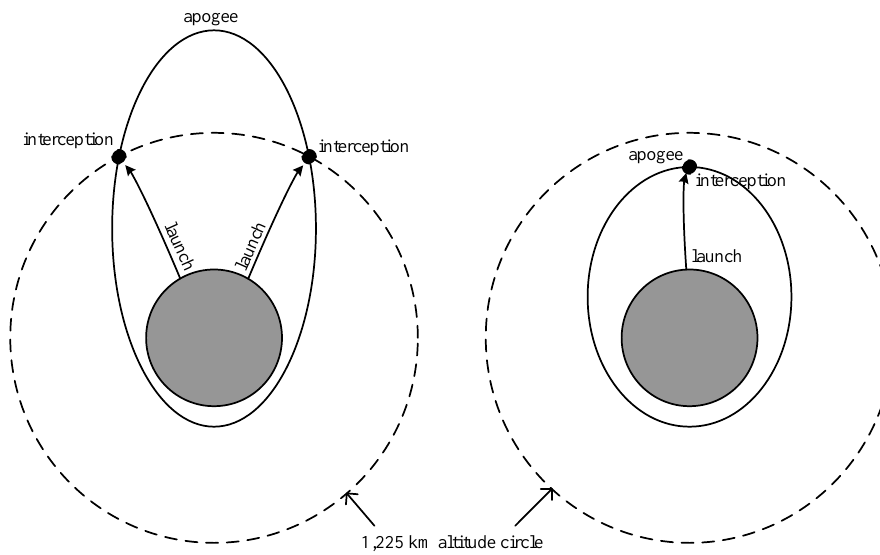
(︀ A )︀ is determined by observing the long-term decay m debris of the debris, C d is 2.2, m payload is 5 kg, and R is 10 m.